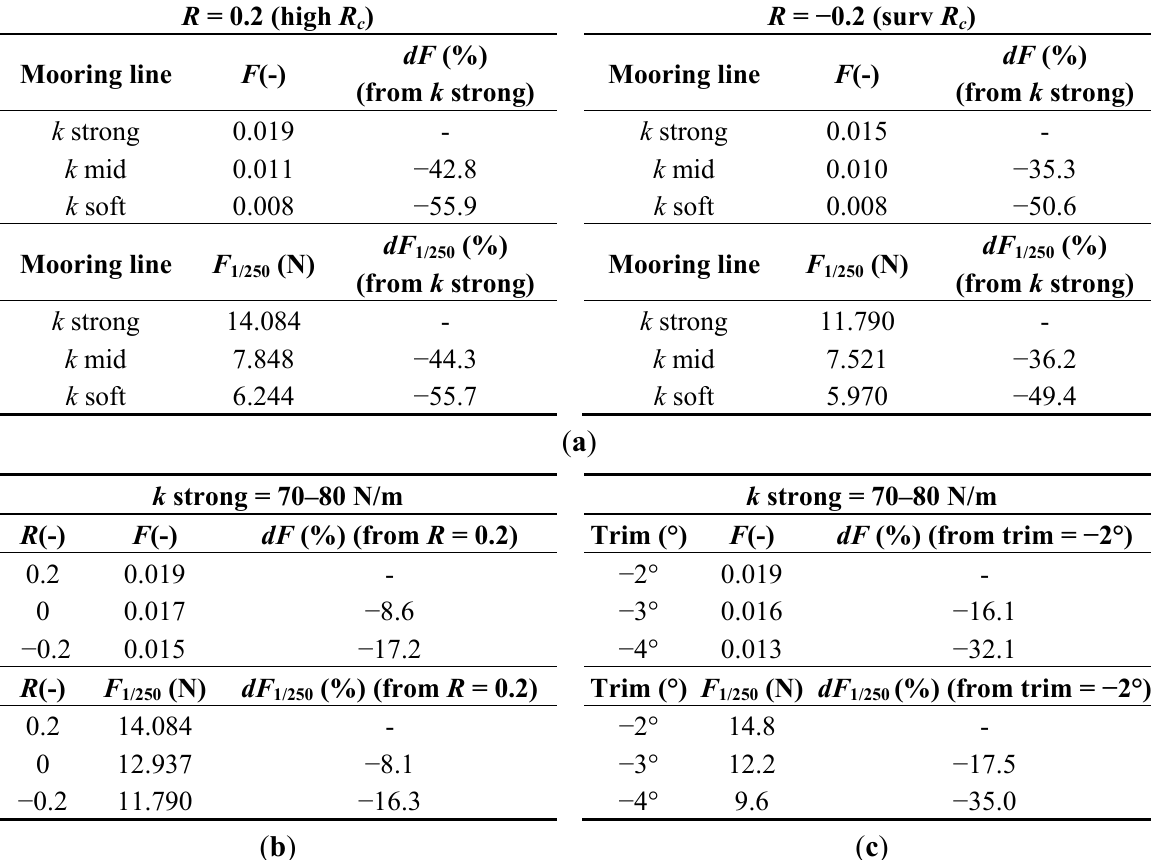
Table 5. Reduction achievable in the extreme mooring tension by means of different